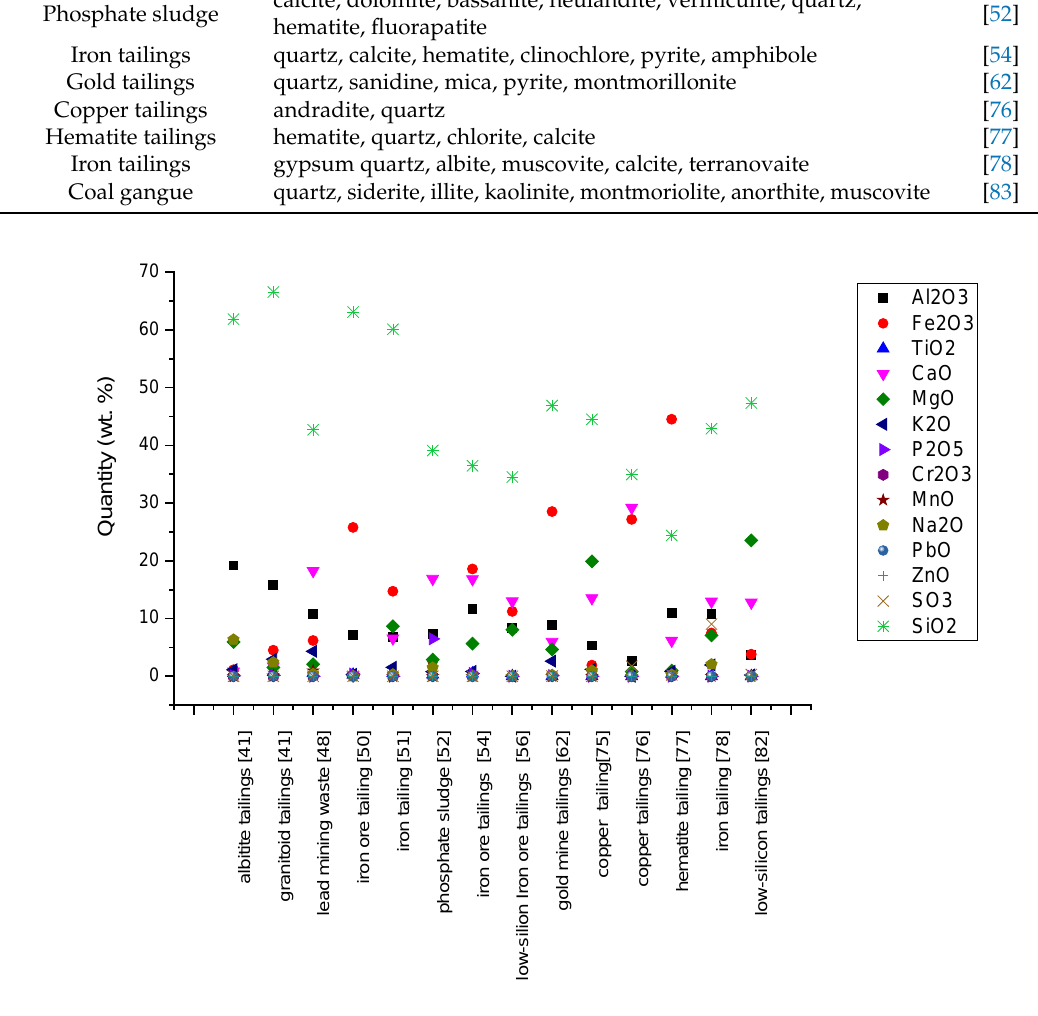
Figure 3. Chemical composition of waste.